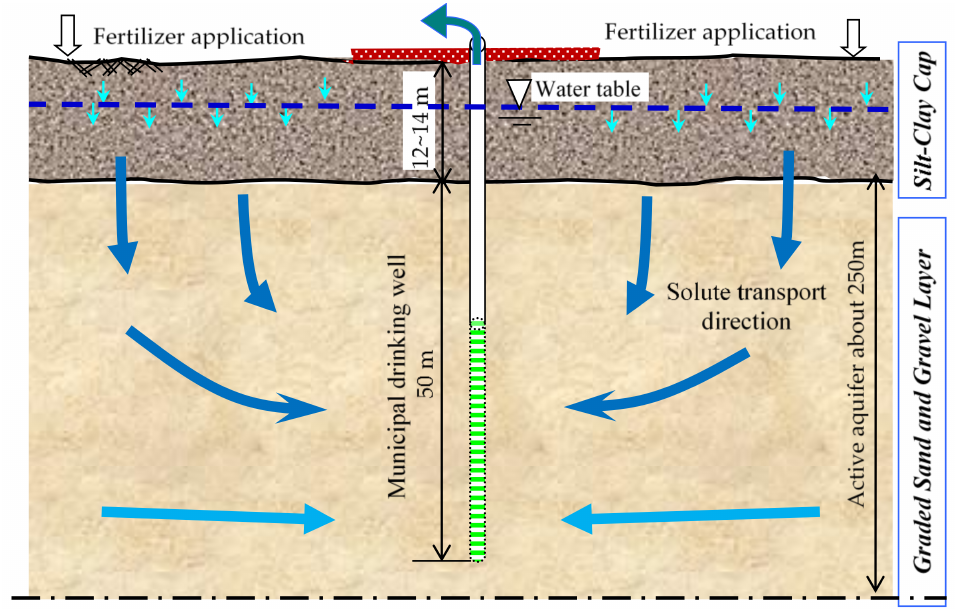
Figure 3. Hydrogeology of study site aquifer indicating fertilizers’ transport to wellfield.